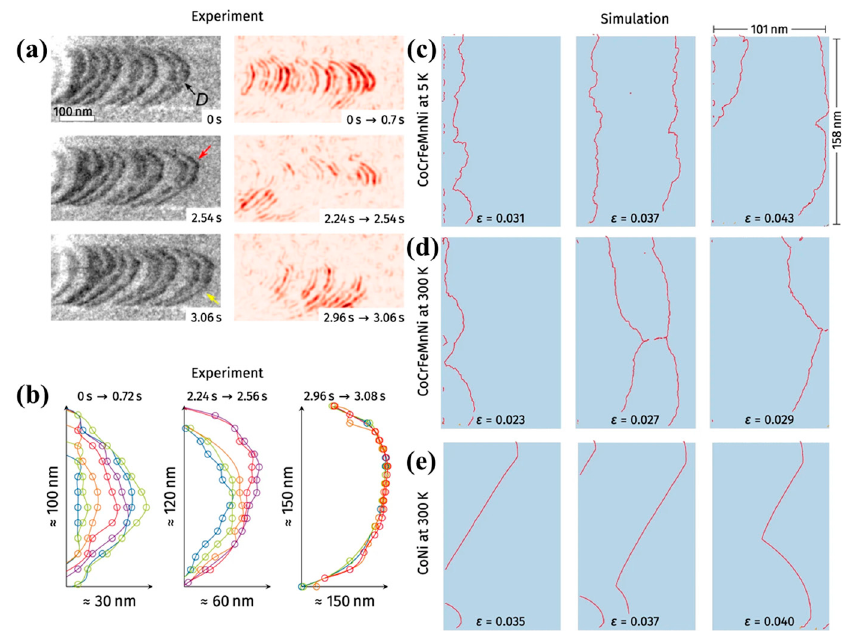
Figure 6. Jerky dislocation motion (Reprinted with permission from Ref. [81]. Copyright 2022, Springer Nature). ( a ) A series of TEM snapshots and schematic figures showing a sequence of gliding Shockley partial dislocations. Black arrow represents dislocation lines, red and yellow arrows denote the movement of dislocations captured at denoted time intervals. ( b ) Extracted dislocation line of the leading partial dislocation which show jerky glide motion because some segments get pinned during glide. ( c , d ) Atomistic simulation results with strong pinning of dislocations and ( e ) weak pinning of dislocations. The presence of CSRO in CoCrFeMnNi alloys results in jerky dislocation motion while the CoNi alloy with weak pinning shows almost ideally straight dislocation lines.